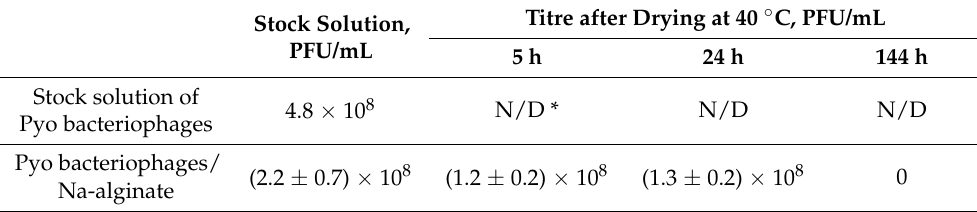
Table 2. Titre of the Pyo bacteriophages during drying of the Na-alginate. Stock Solution,